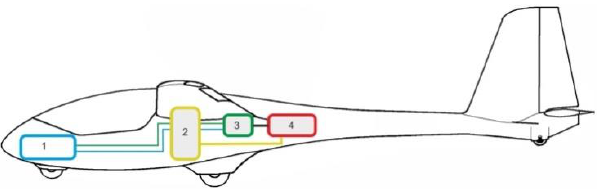
Fig. 4. Diagram of the hybrid propulsion system with an internal combus- tion engine for the AOS motor glider: 1 – battery, 2 – fuel tank, 3 – Emrax 188 engine working in generator mode, 4 – Wankel AG 407 TGi engine